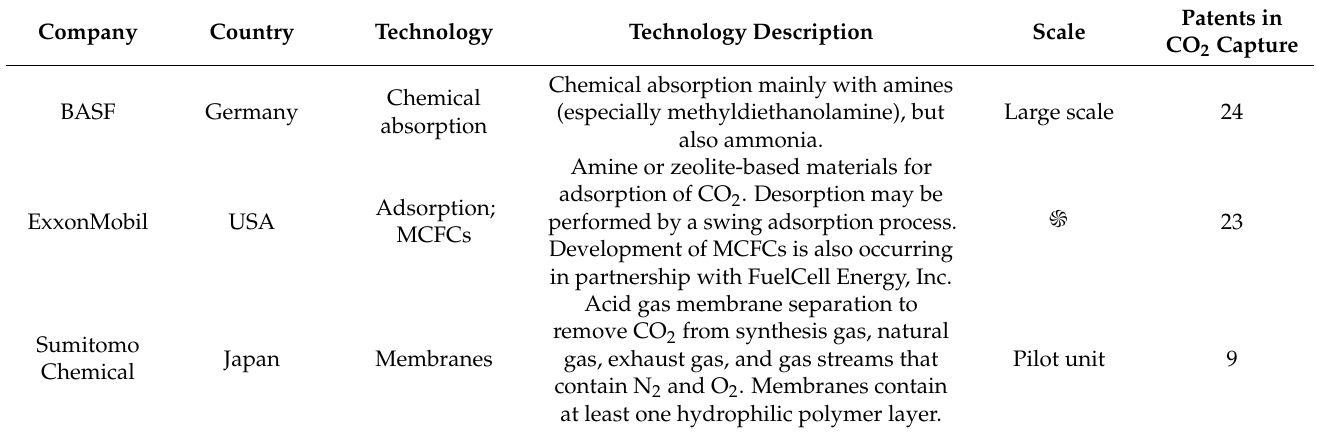
Table 17. Technology description of CO 2 capture solutions developed by chemical and plastic producers. Company